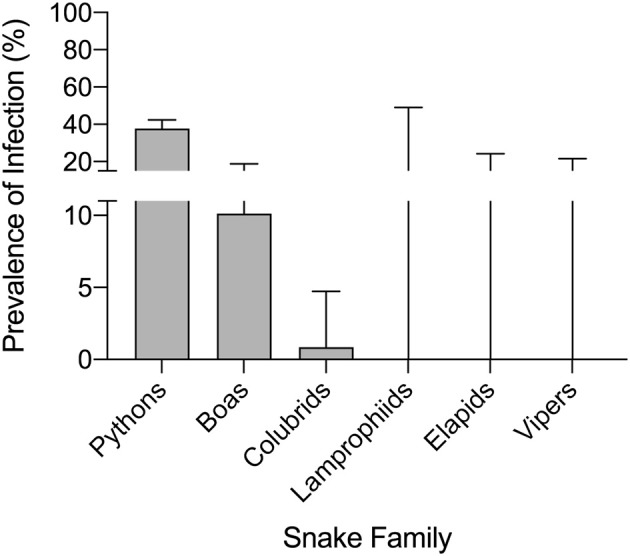
Captive pythons in some collections have a high prevalence of serpentovirus infection. A significant association was observed between infection status and snake family (p-value ≤ 0.001). Prevalence of serpentovirus in snakes of each family: pythons 37.7% (156 infected/414 total snakes tested; 95% confidence interval [CI]: 33.1–42.4%), boas 10.1% (8/79; 95% CI: 5.2–18.7%), colubrids 0.9% (1/116; 95% CI: <0.01–4.7%); infection was not detected in lamprophiids (0/4; 95% CI: 0–49%), elapids (0/12; 95% CI: 0–24.2%), or vipers (0/14; 95% CI: 0–21.5%). Bars indicate 95% CI.